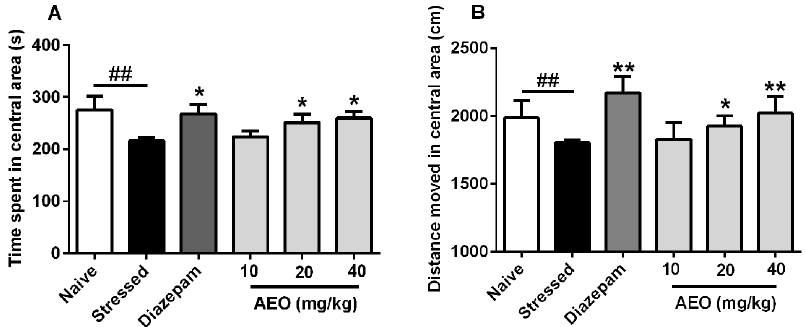
Figure 3. Effects of AEO on restraint stress-induced anxiety as assessed by the open field (OF) test. All mice except for the naive group received 10 days restraint stress, then ( A ) time spent and ( B ) distance moved in the central area were recorded over a 10 min session. Each value represents mean ± SEM with n = 12, ## p < 0.01 vs. the naive group, * p < 0.05 and ** p < 0.01 vs. the stressed group.